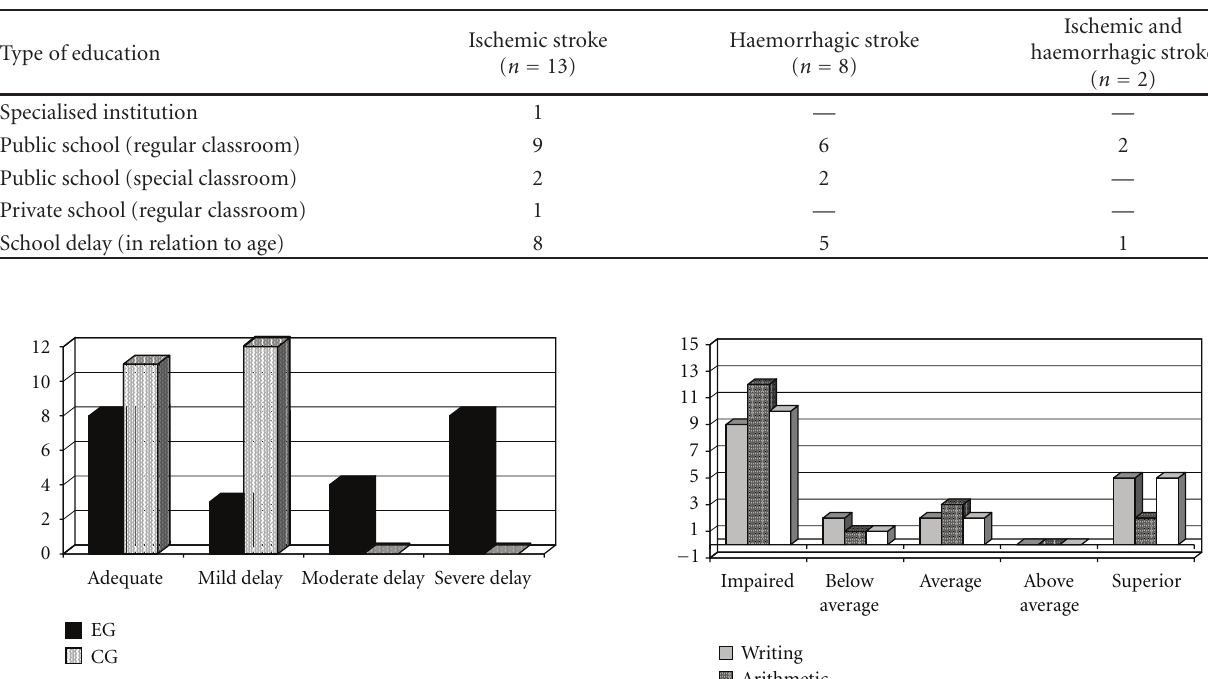
Table 3: School data of the 23 children in the experimental group.